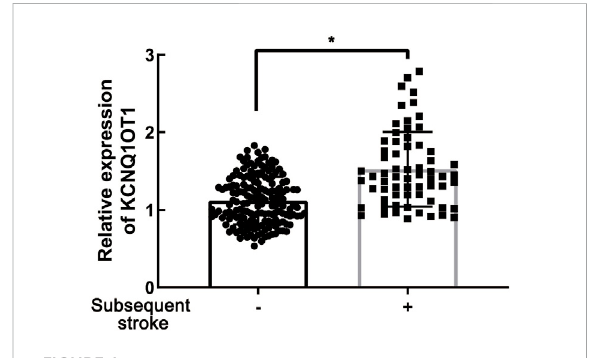
FIGURE 1 KCNQ1OT1 was prominently upregulated in TIA patients with subsequent ischemic stroke events, * p < 0.05.